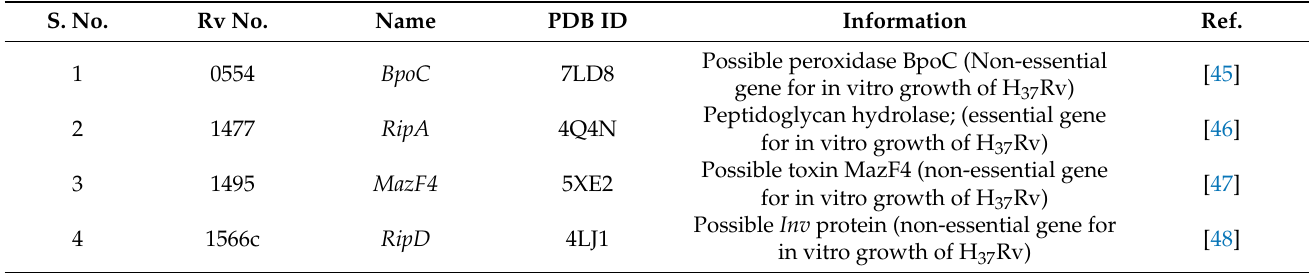
Table 3. Assessment of multitarget signature Mtb proteins based on virulence, detoxification, and adaptation